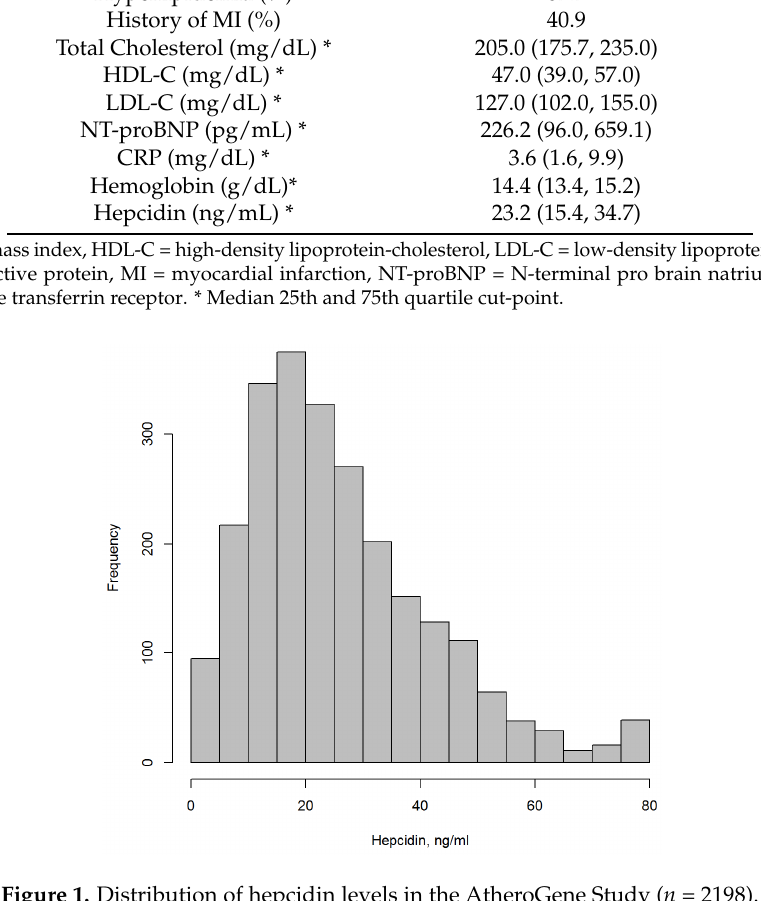
Table 1. Baseline characteristics of the study patients.